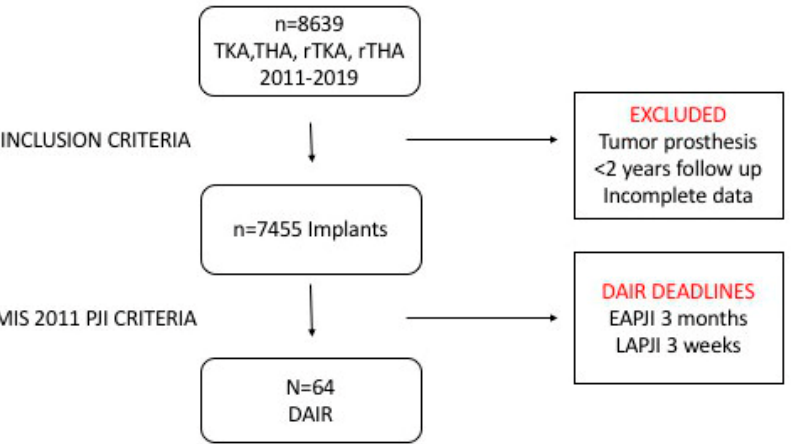
Figure 1. Patient recruitment flowchart. DAIR: Debridement, antibiotics and implant retention, EAPJI: Early acute prosthetic joint infection, LAPJI: Late acute prosthetic joint infection, PJI: Prosthetic joint infection, THA: Total hip arthroplasty, TKA: Total knee arthroplasty, rTHA: Revision total hip arthroplasty, rTKA: Revision total knee arthroplasty.